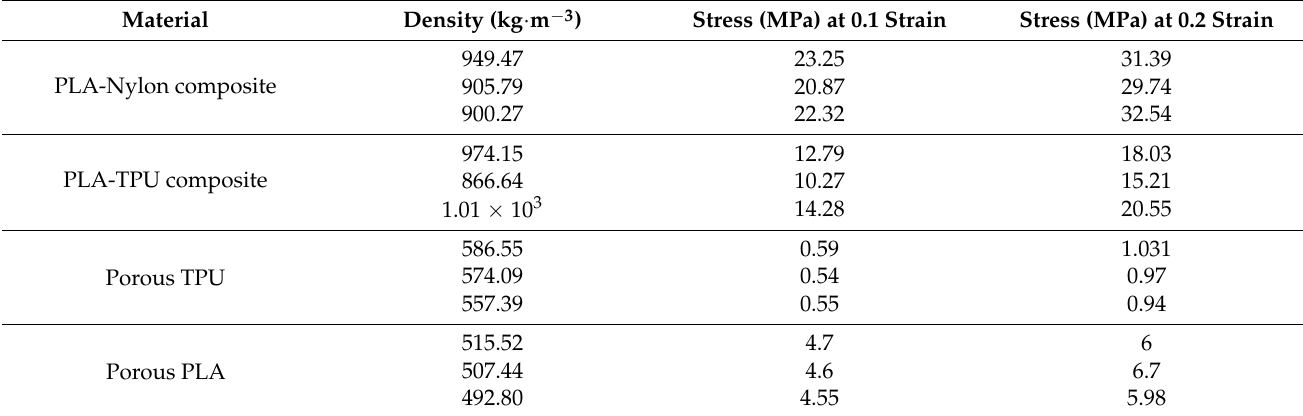
Table 2. Specimen densities and nominal stress response at 0.1 and 0.2 nominal